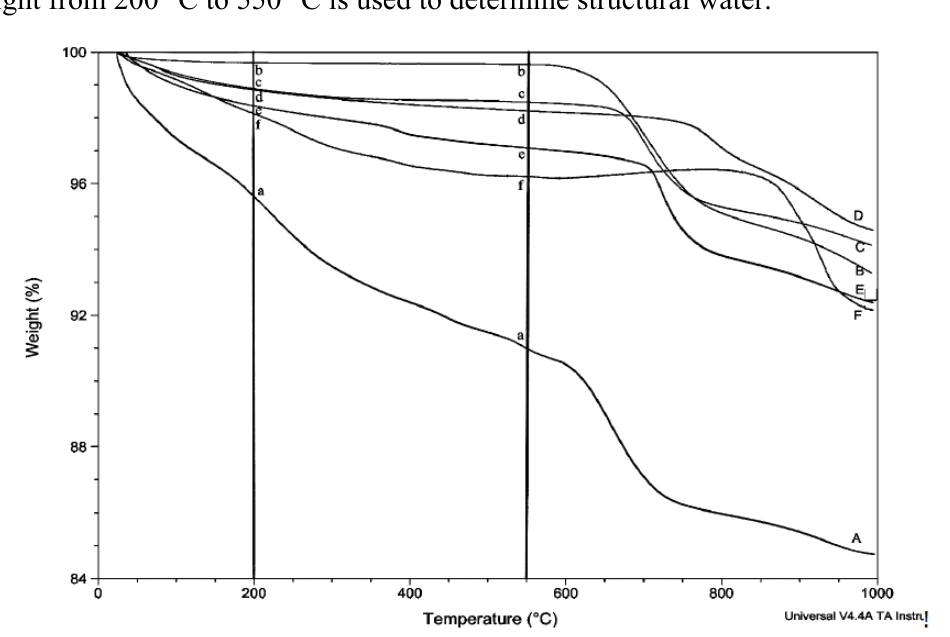
Figure 6. TGA scans for CCaApOH sample containing 13.4 wt% carbonate after it